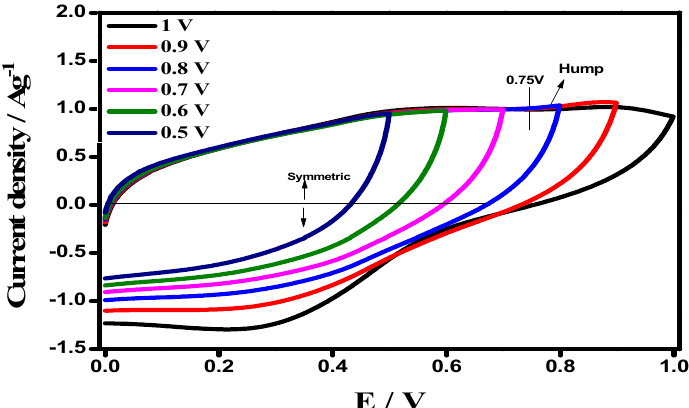
Figure 9. CV of the symmetric device in the upper potential range 0.5–1.0 V, keeping a lower potential at 0.0 V.